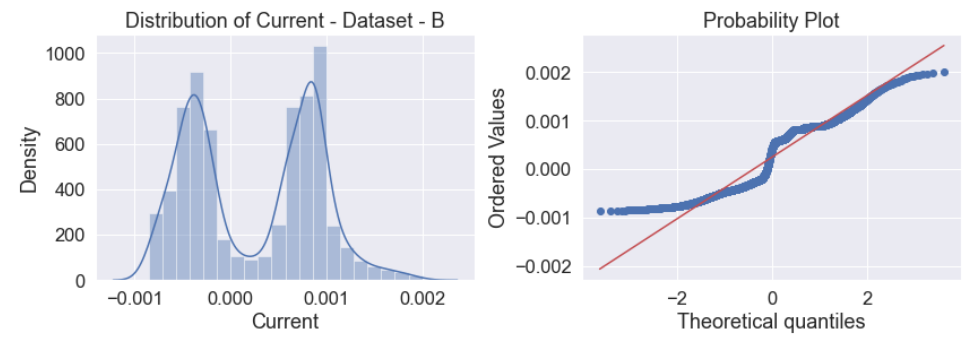
Figure 15. Density and probability plots of Dataset B.